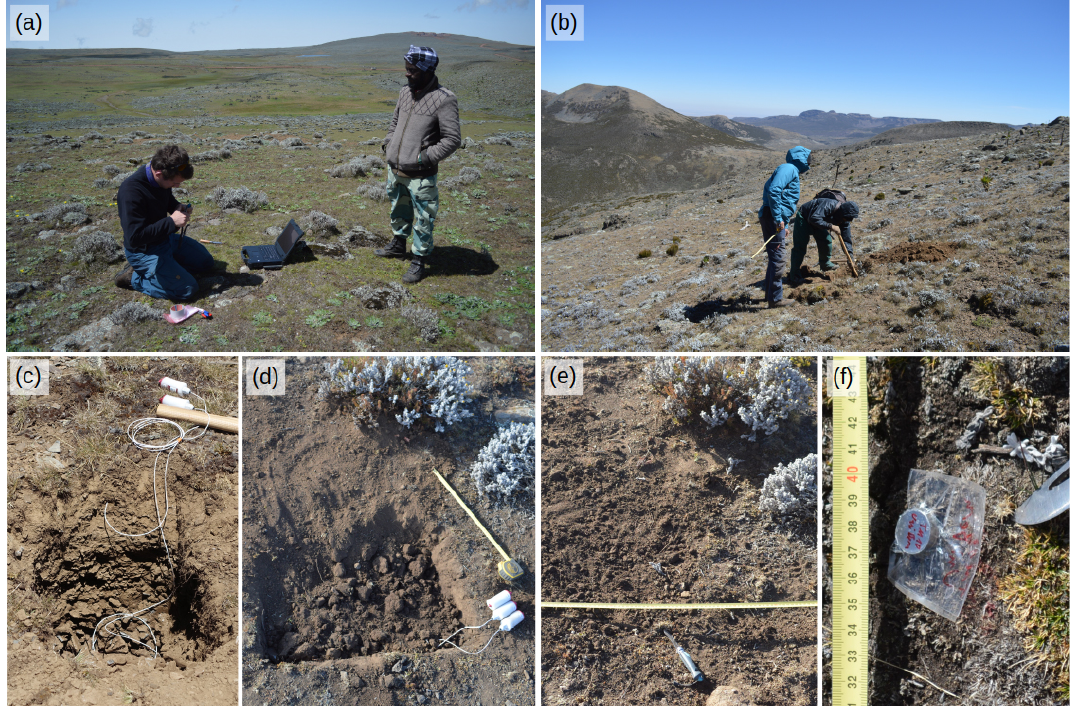
Figure 2. Overview of the installation and maintenance of the ground temperature monitoring network in the Bale Mountains. (a) Environ- mental setting of logger TM14t (2cm) at ca. 4100m on the Sanetti Plateau. (b) Environmental setting of data loggers GT01t (2cm), GT01m (10cm), and GT01b (50cm) at ca. 4200m on the northern slope of Mount Wasama. (c–e) Exemplary installation procedure of data loggers at different depths. (f) Close-up view of a tiny TM data